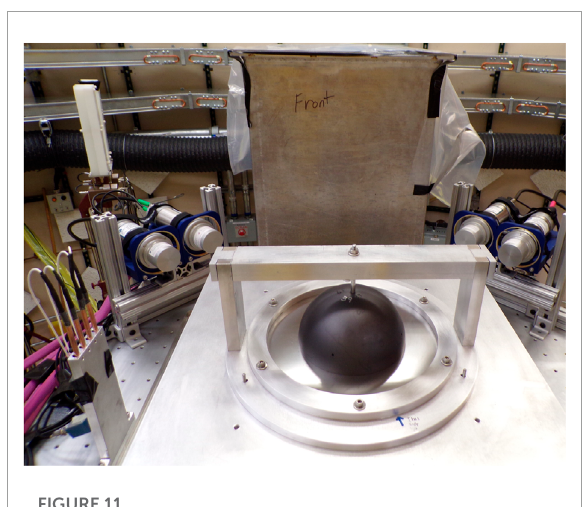
FIGURE 11 Photo of the experimental setup during the MUSiC